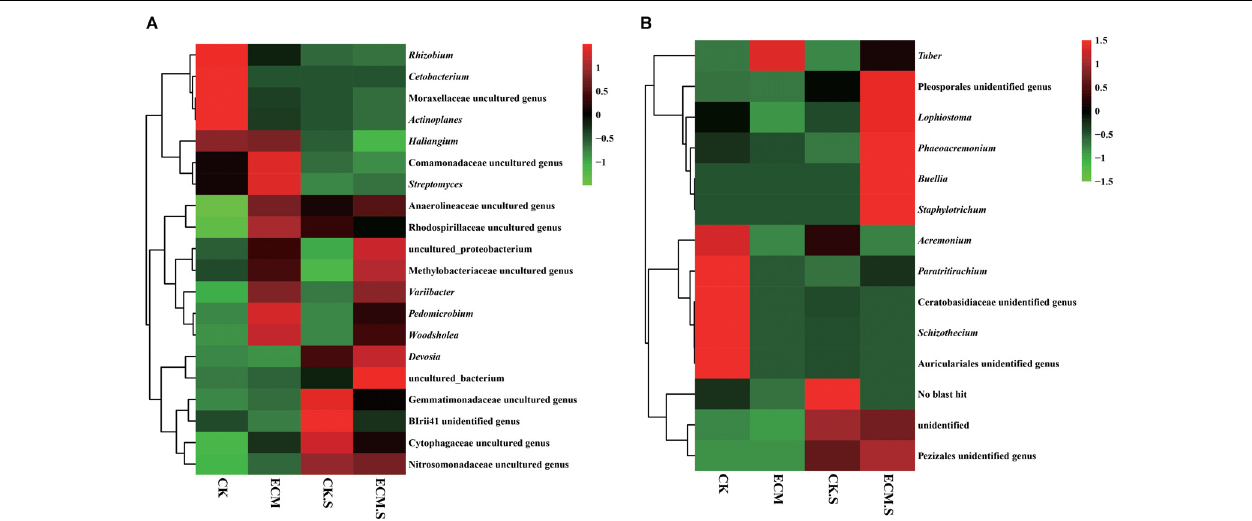
FIGURE 3 | Heat-map analysis of the most abundant (average relative abundance > 0.01) bacterial (A) and fungal (B) genera in Q. aliena roots and the surrounding soil. ECM, ectomycorrhiza; ECM.S, ectomycorrhizosphere soil; CK, roots of Q. aliena without T. indicum partner; CK.S, rhizosphere soil of Q. aliena without T. indicum partner. The relative abundance of the samples at genus level increased with the increase of the color block